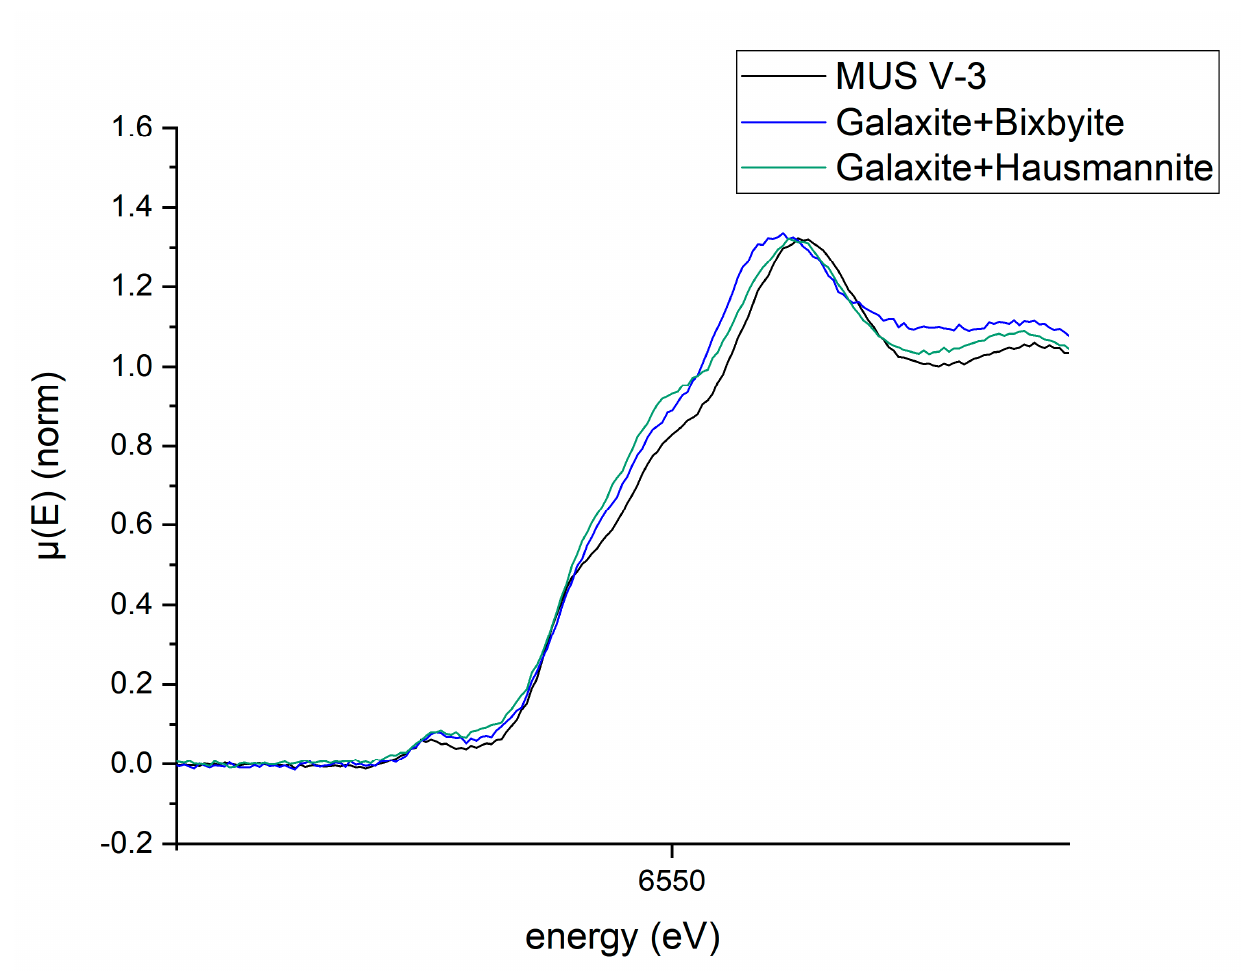
Figure 10. Close-up to the edge jump from Figure 9.